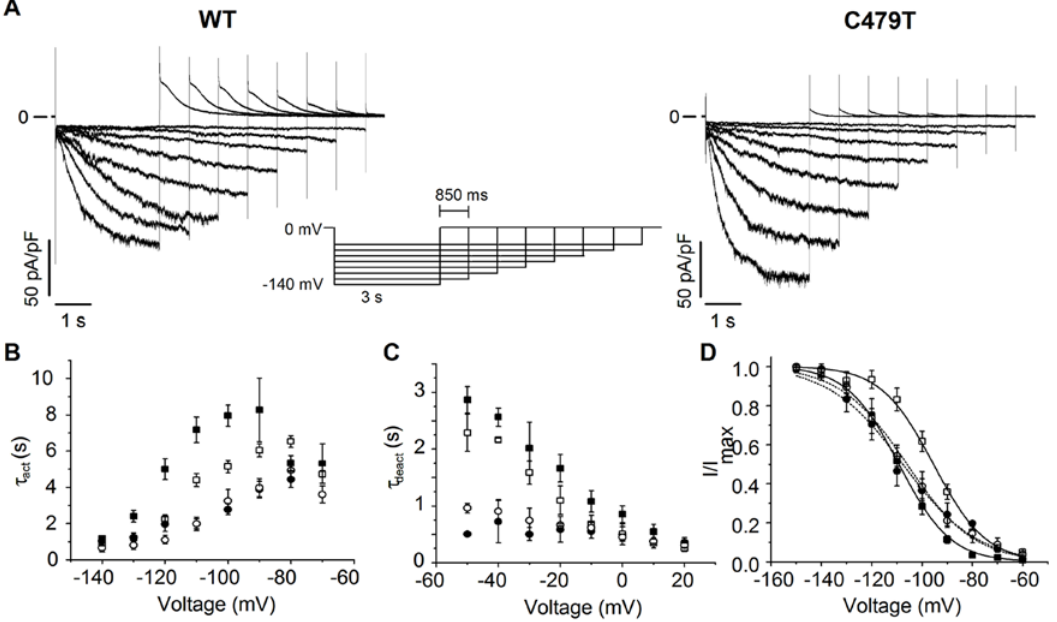
Figure 6. Gating properties of WT and C479T HCN4 channels. (A) Representative WT and C479T activation currents elicited by the protocol in the inset. Traces shown were recorded with 5 mM K + /135 mM Na + in the extracellular and 140 mM K + intracellular solutions. Similar recordings were performed with 140 mM K + in the extracellular solution. (B) Activation time constants ( t act ) measured using a mono-exponential fit of currents following the initial delay. C479T channels (circles) activated faster* than WT (squares) in 140 mM extracellular K + (filled symbols) (n=5 and 8 respectively). WT activation kinetics were faster* when most of the extracellular K + was replaced with Na + (5 mM K + /135 mM Na + ; open symbols) (n=9). C479T activated with the same kinetics following substitution of K + with Na + (n=5). (C) Deactivation time constants ( t deact ) measured using a mono-exponential fit of currents similar to those in Figure 1 following the initial delay. C479T channels deactivated faster* than WT in both 140 mM K + (n=5 and n=7 respectively) and 5 mM K + /135 mM Na + (n=7 and n=6 respectively) extracelluar conditions. (D) Steady-state activation curves N from peaks of tail currents elicited at + 30 mV following pulses from 2 150 to 2 60 mV using a varying pulse duration protocol. WT ( & ) channels ) channels in 140 mM K + (V 1/2 = 2 110 6 3 mV and 2 108 6 4 mV respectively; P=0.69), however, had steeper* activated with the same V 1/2 as C479T ( slope factors ( k =9.0 6 0.8 and 12.9 6 0.6 respectively). Upon ion substitution to 5 mM K + /135 mM Na + , WT channels ( % ) activated at a + 14 mV* more depolarized potential